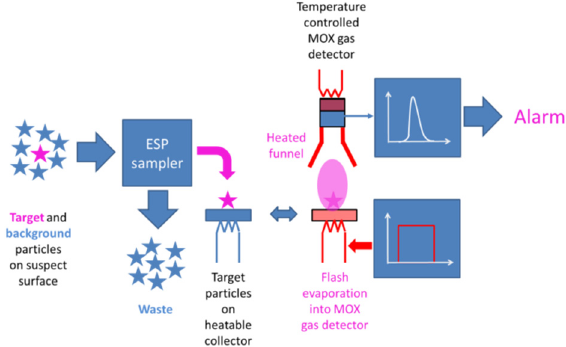
Figure 1. Sensor system for sampling, sorting and converting low vapor pressure target particles into detectable vapors. ESP, electrostatic precipitation.